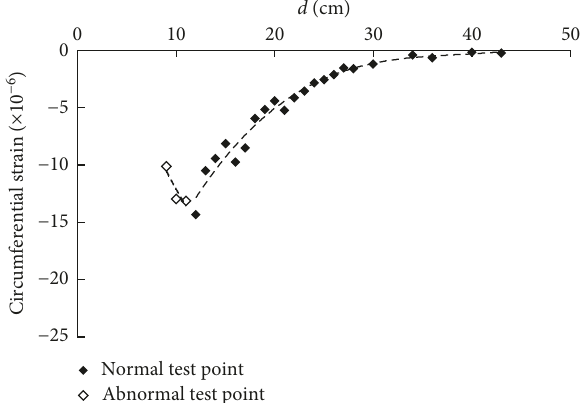
Figure 9: The test result of circumferential strain on the top of the CC pavement structure model.